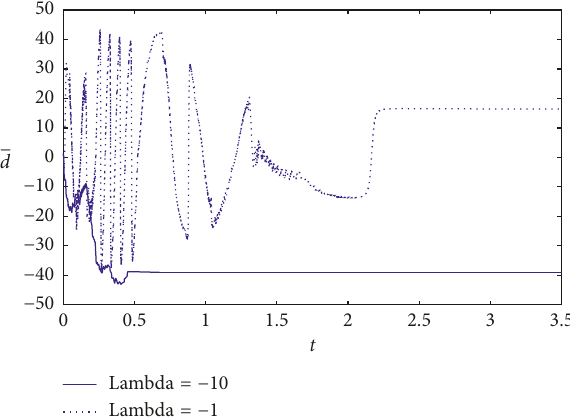
Figure 7: The time response of state d of system (29) with x ,x , x 1 ( 0 ) (cid:26) 5 2 ( 0 ) (cid:26) 0 3 ( 0 ) (cid:26) −